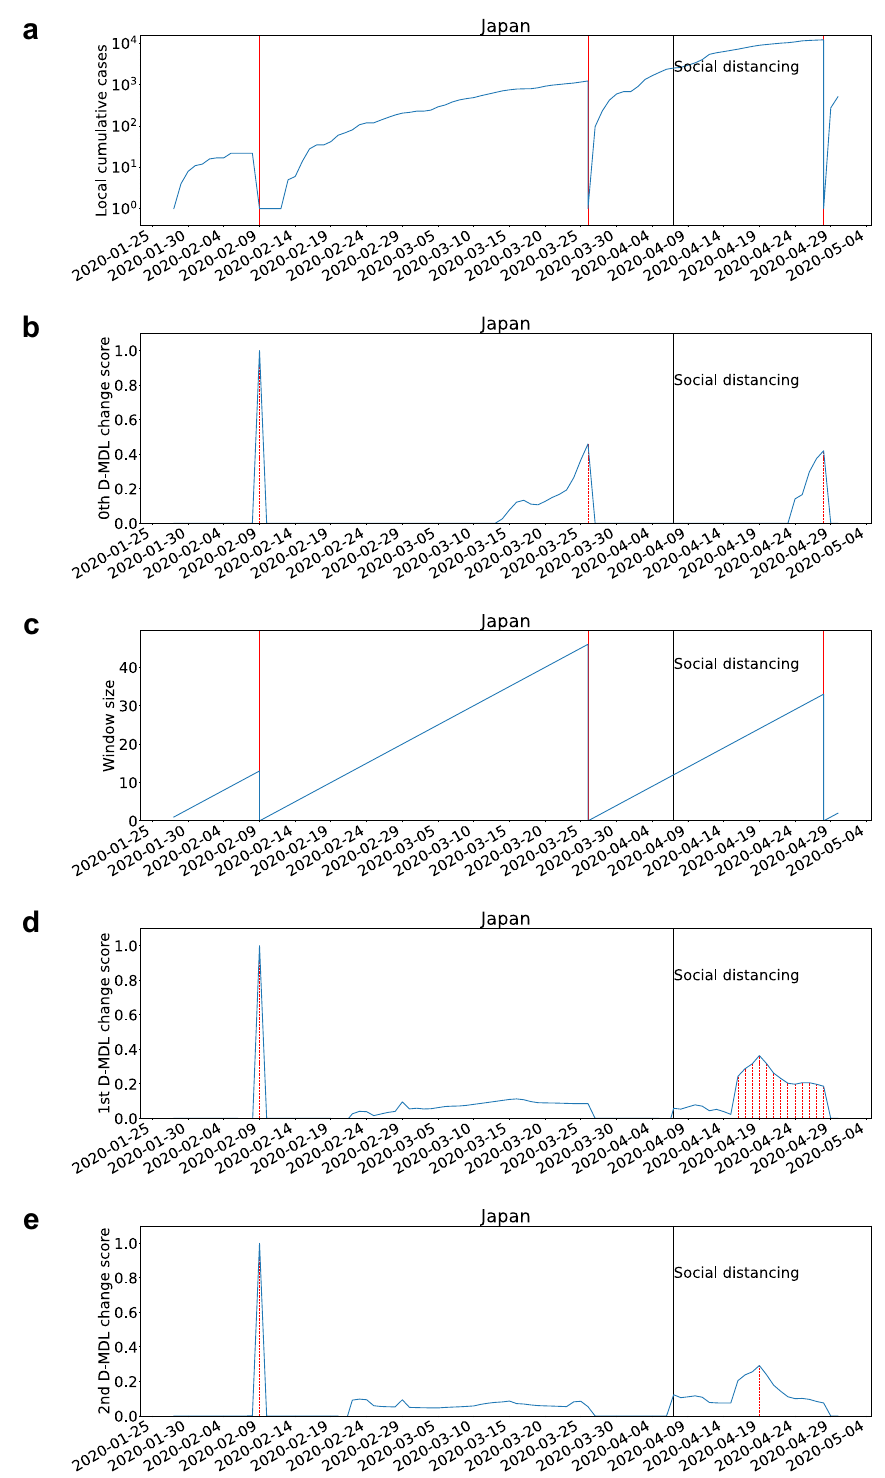
Figure 2. The results for Japan with the exponential modeling. The label “Local cumulative cases” in subfigure (a) means that the cumulative cases only accumulate daily cases from each starting date of change detection and would be set to zero after each change detected by the 0th D-MDL. The date on which the social distancing was implemented is marked by a solid line in black. ( a ) The number of cumulative cases. ( b ) The change scores produced by the 0th D-MDL where the line in blue denotes values of scores and dashed lines in red mark alarms. ( c ) The window sized for the sequential D-MDL algorithm with adaptive windowing where lines in red mark the shrinkage of windows. ( d ) The change scores produced by the 1st D-MDL. ( e ) The change scores produced by the 2nd